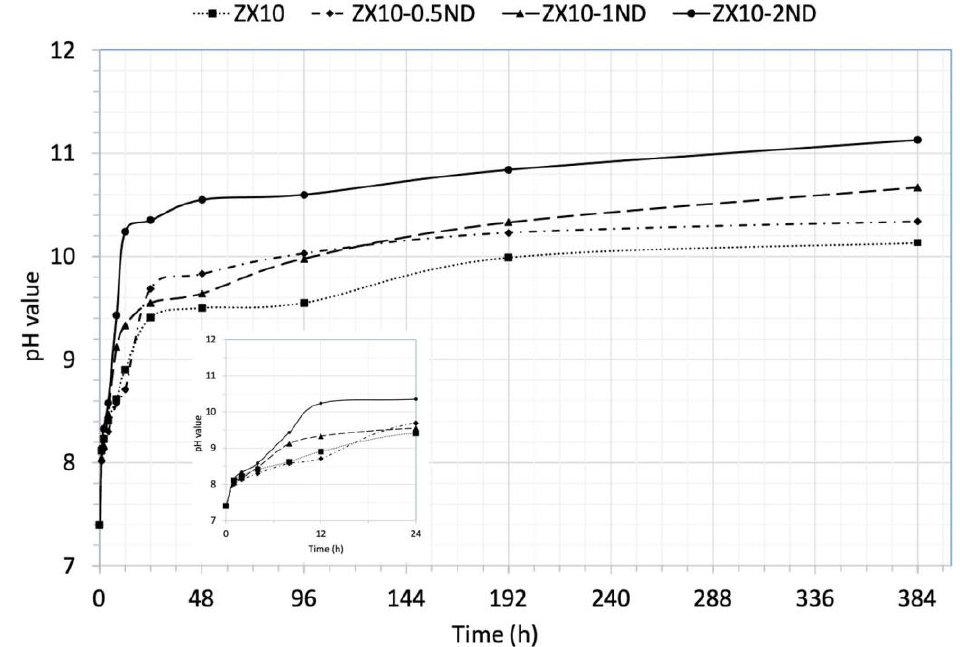
Figure 10. The pH value of HBSS as a function of immersion time for ZX10 alloy and ZX10-0.5ND, ZX10-1ND, and ZX10-2ND.